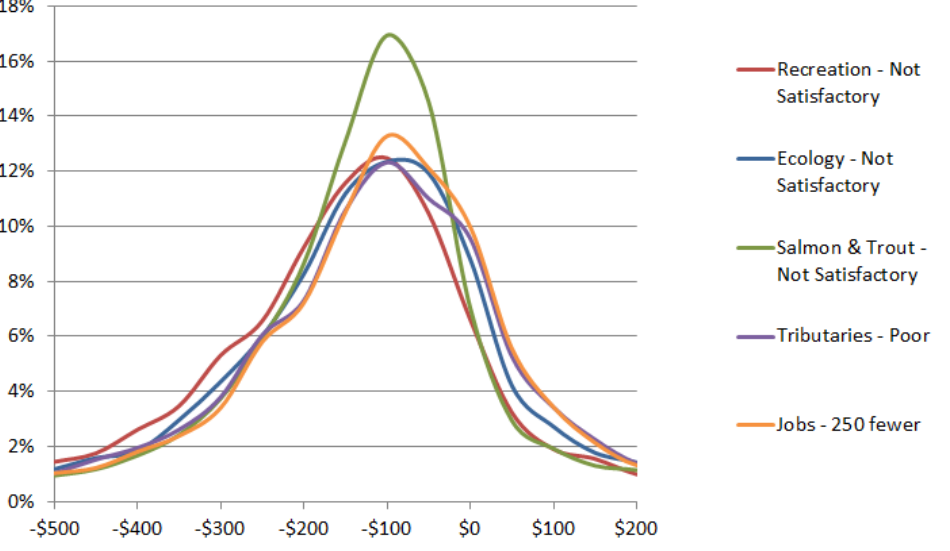
Figure 4. Distribution of WTA for Declines (Model